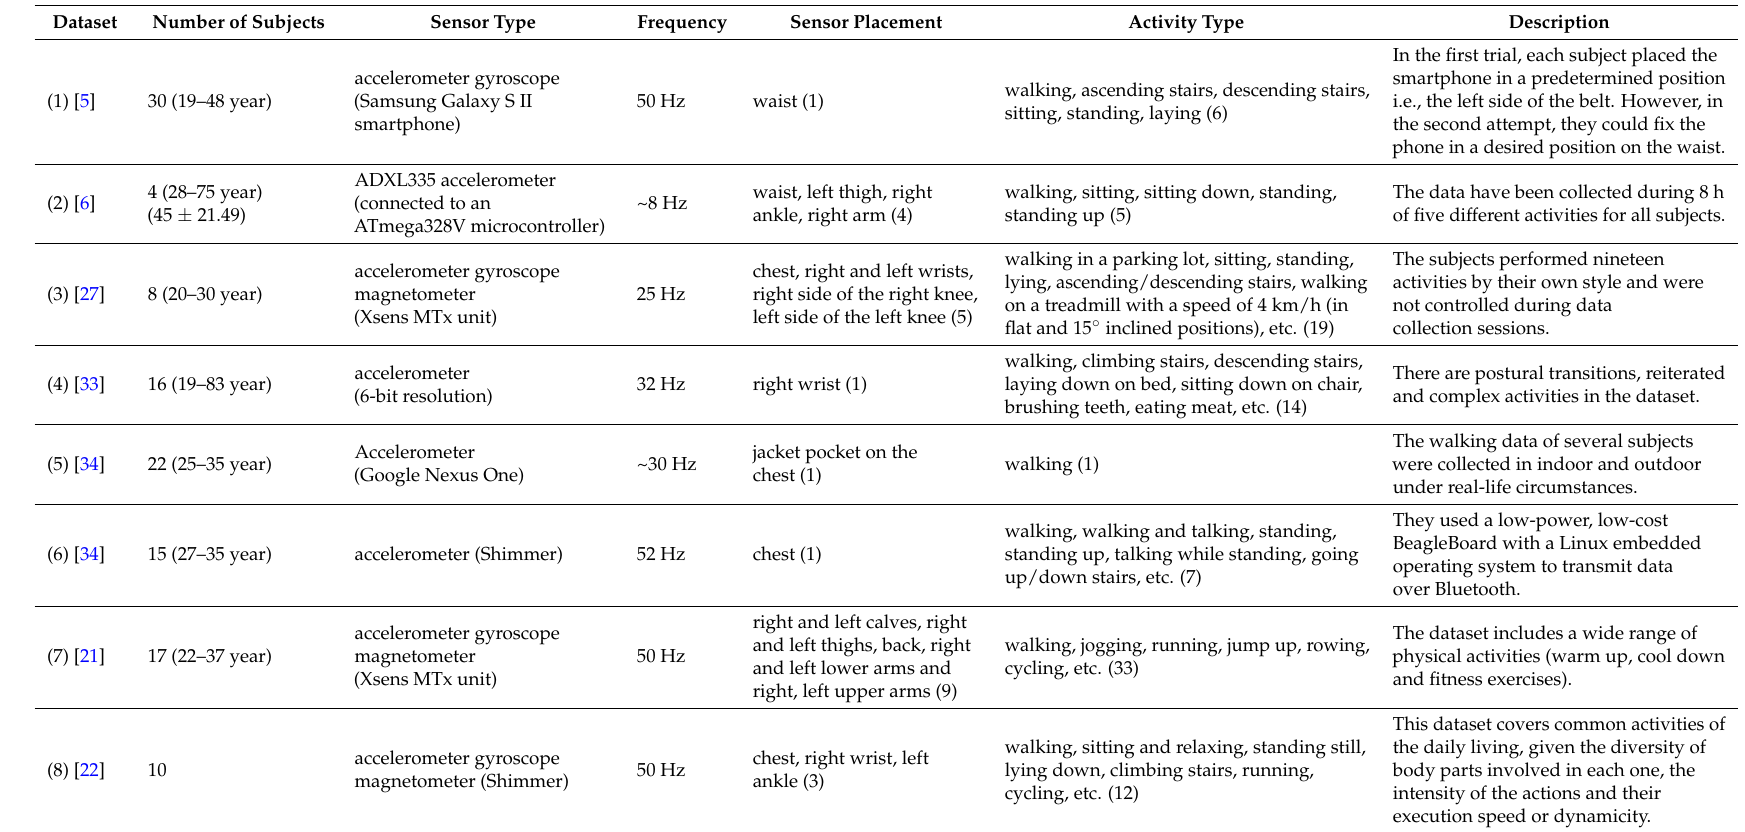
Table 2. The datasets used in this